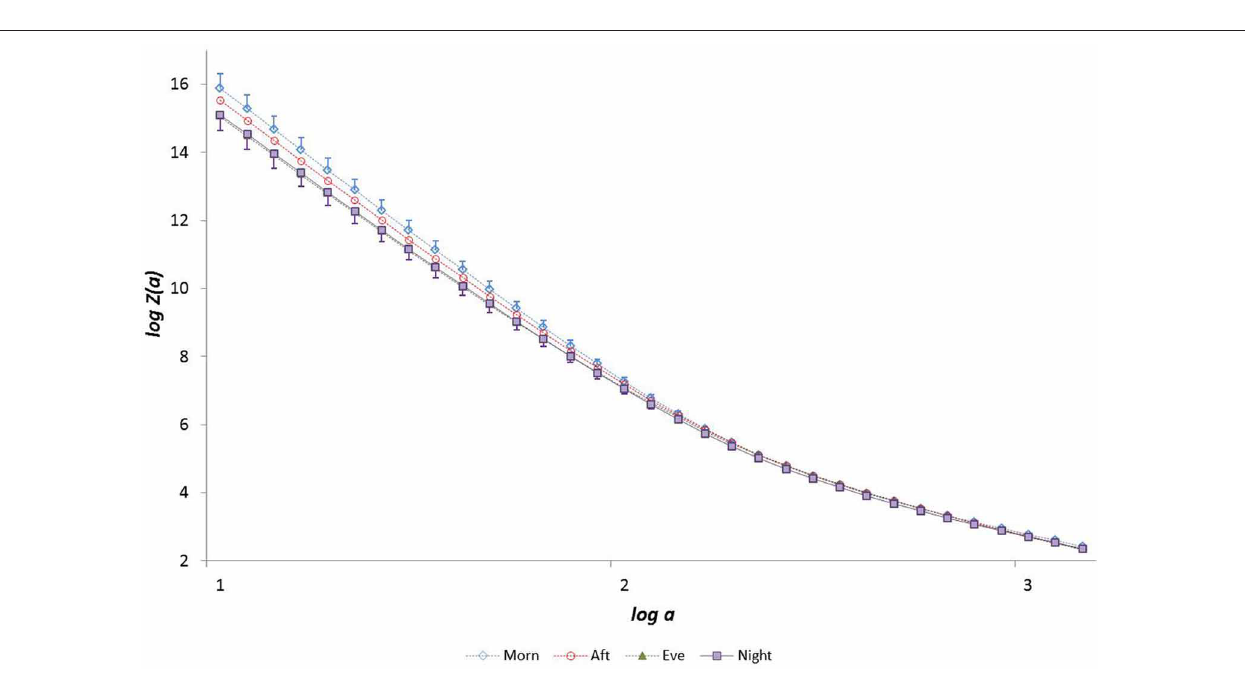
and Evening ( r = 0 . 33, p = 0 . 005) periods but was weaker dur- ing the Night ( r = 0 . 19, p = 0 . 110). The 24-h mean values for h ∗ and FWHM for the original, order-shuffled surrogate and AAFT surrogate data were: h ∗ = 0 . 055 ± 0 . 001 vs. 0 . 284 ± 0 . 004 vs. 0 . 218 ± 0 . 004, and FWHM = 0.318 ± 0.005 vs. 0 . 713 ± 0 . 012 vs. 0 . 675 ± 0 .